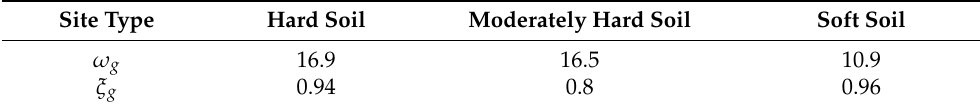
Table 1. Parameters of the Kanai–Tajimi